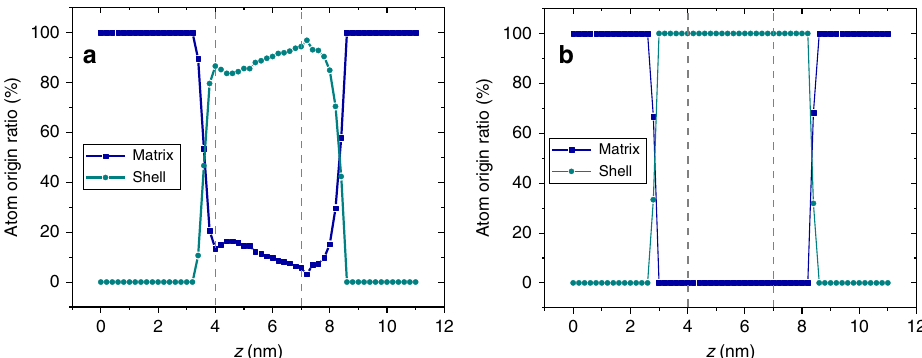
Fig. 8 Origin of atoms along concentration pro fi les based on simulated APT reconstruction. a is for a void with a low-evaporation- fi eld and b is for a void with a high-evaporation- fi eld